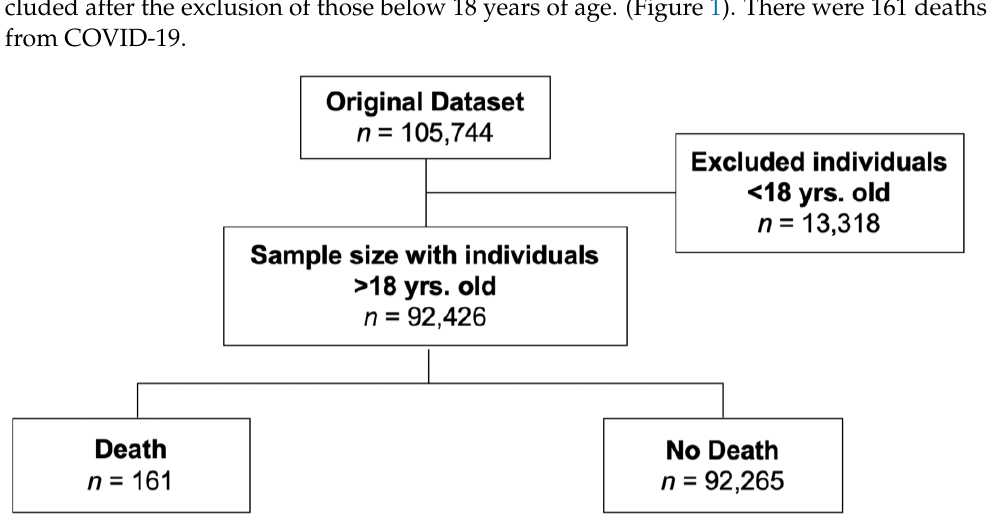
Figure 1. Flow chart showing how participants were included. As expected, the mean age of the participants who died was significantly older than that of those who were alive during the study period (65.4 years (SD 14.5) vs. 37.0 (SD 11.0), respectively, p < 0.001). Approximately 80% of the cohort were males, reflecting the gender distribution in the country, with no statistical difference in the distribution of females and males between participants who died and those who were alive during the study period (Table 1). Approximately 72% of the individuals who died had at least one comorbidity, compared to 13.6% of controls (Table